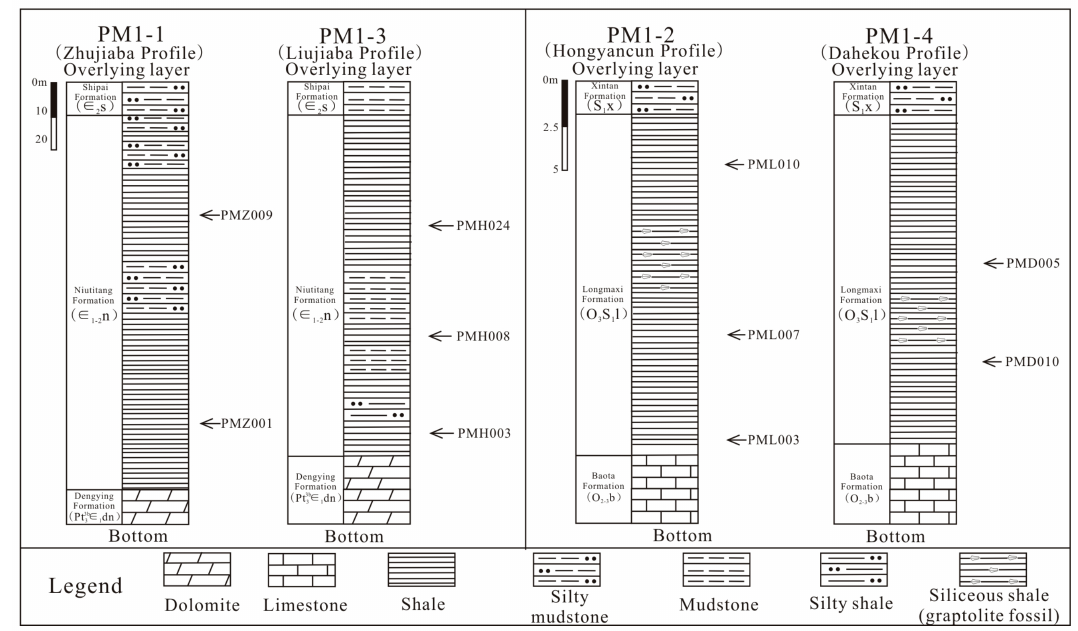
Figure 2. The sampling locations of Niutitang Formation and Longmaxi